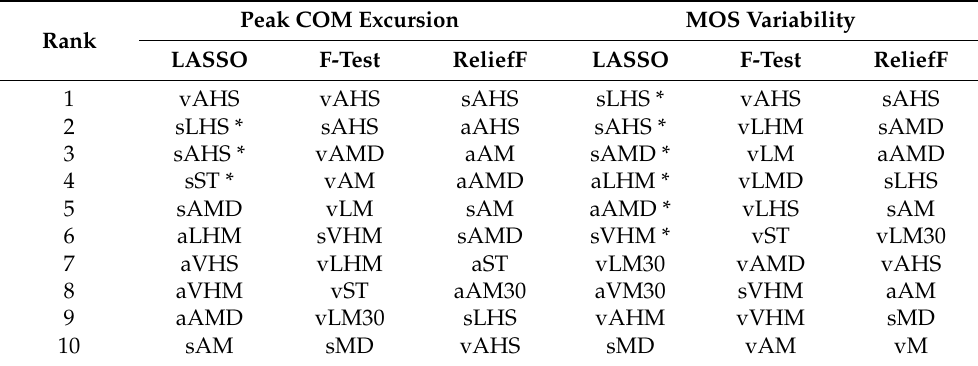
Table 3. Top 10 selected features for peak COM excursion and MOS variability using LASSO, F-test, and ReliefF (* indicates that rank is the same each other).